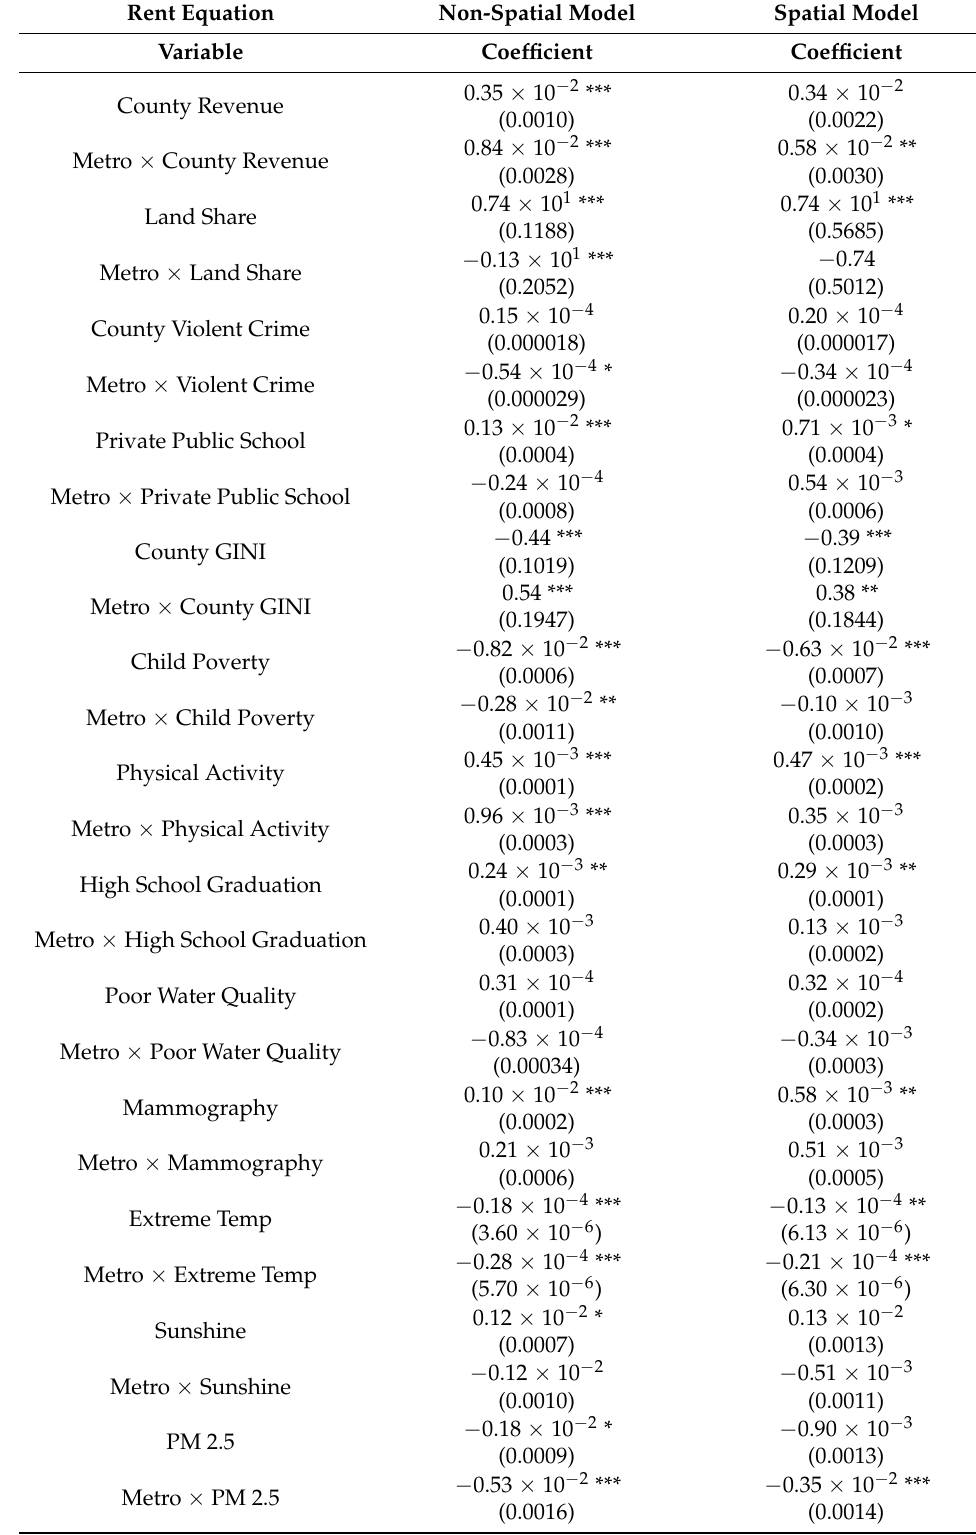
Table A14. Reduced-form estimates for rent equations with a metro dummy and cross-products for the continental United